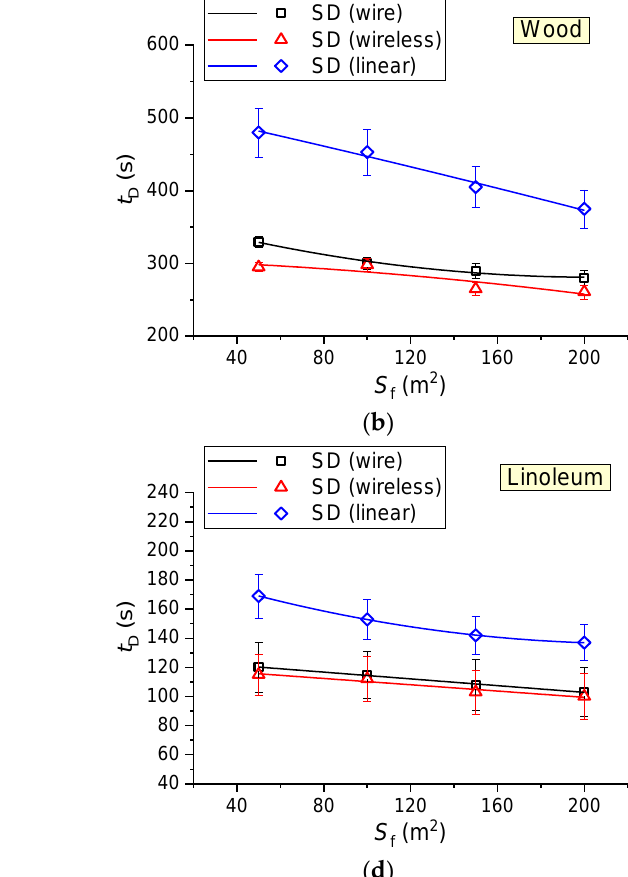
Figure 9. SD activation delay times when varying the area of contact of the fire with the hot plate using model fires involving paper ( a ), wood ( b ), cardboard ( c ) and linoleum ( d ): SD (wireless) is a wireless smoke detector; SD (wire) is a smoke detector connected in the circuit; SD (linear) is a linear smoke detector.